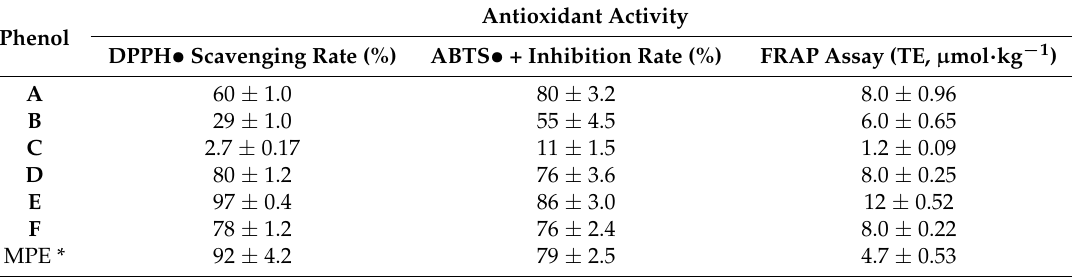
Table 1. Antioxidant activity of six phenol compounds ( n = 3).